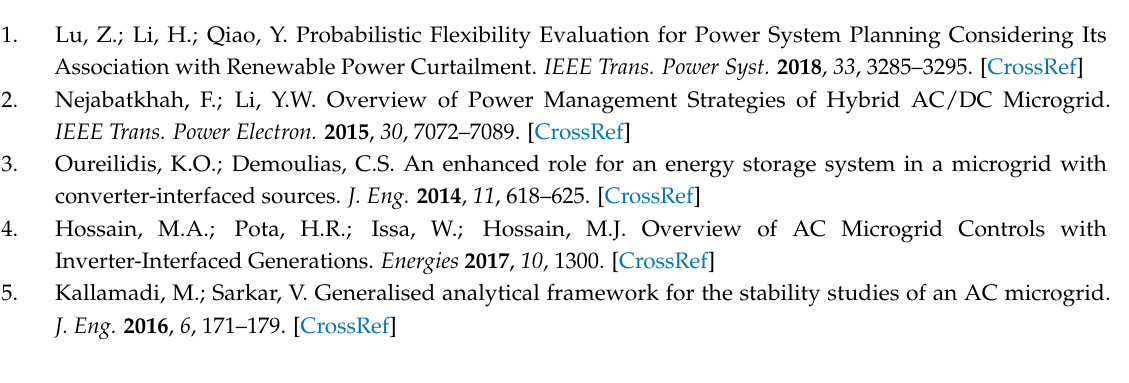
Figure 15. FFT analysis of Experimental result. ( a ) Amplitude; ( b ) phase delay.